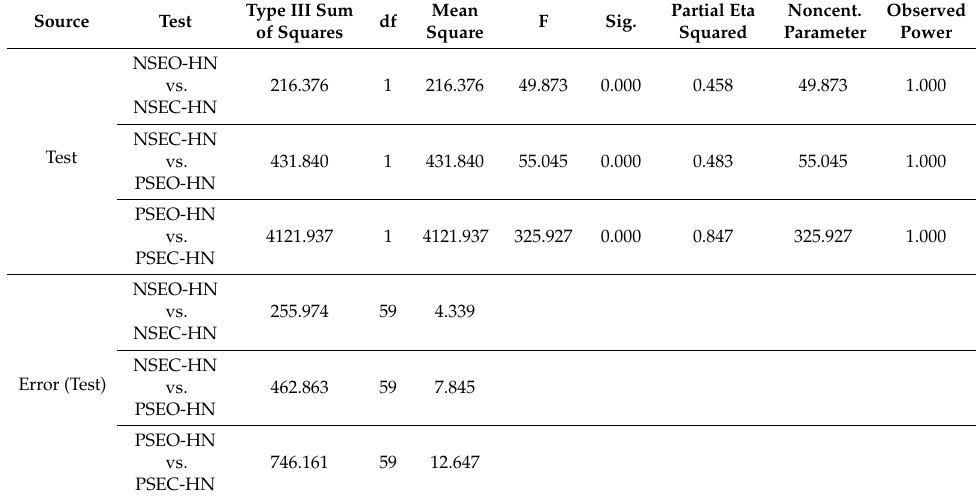
Table 5. Tests of within-Subjects Contrasts for Healthy Controls’ Postural Stability Scores Head Neutral